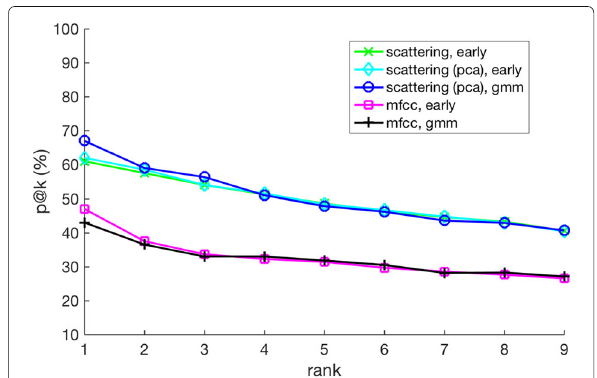
Fig. 4 Acoustic scene similarity retrieval in the DCASE 2013 private dataset: precisions at rank k ( p @ k ) obtained for several baseline approaches, as a function of the rank